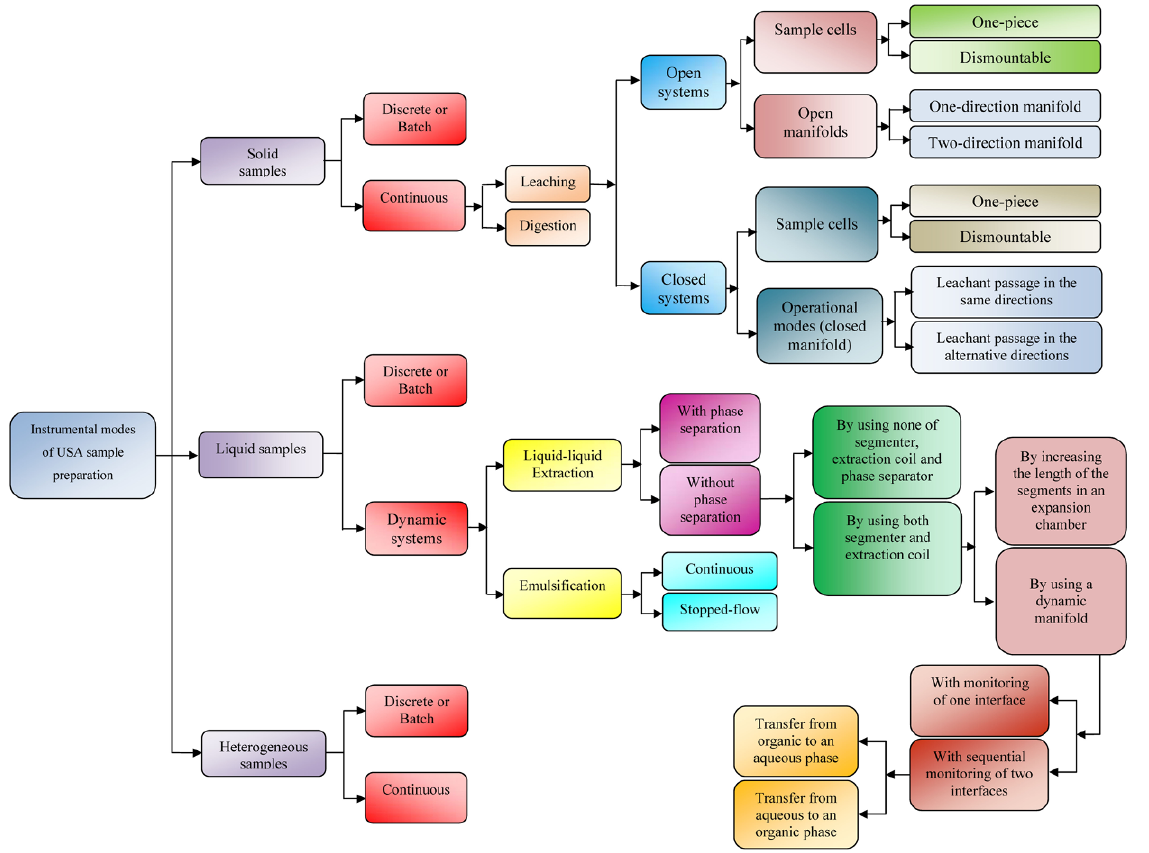
Figure 4. A schematic presentation for different instrumental modes of various sample preparation techniques.